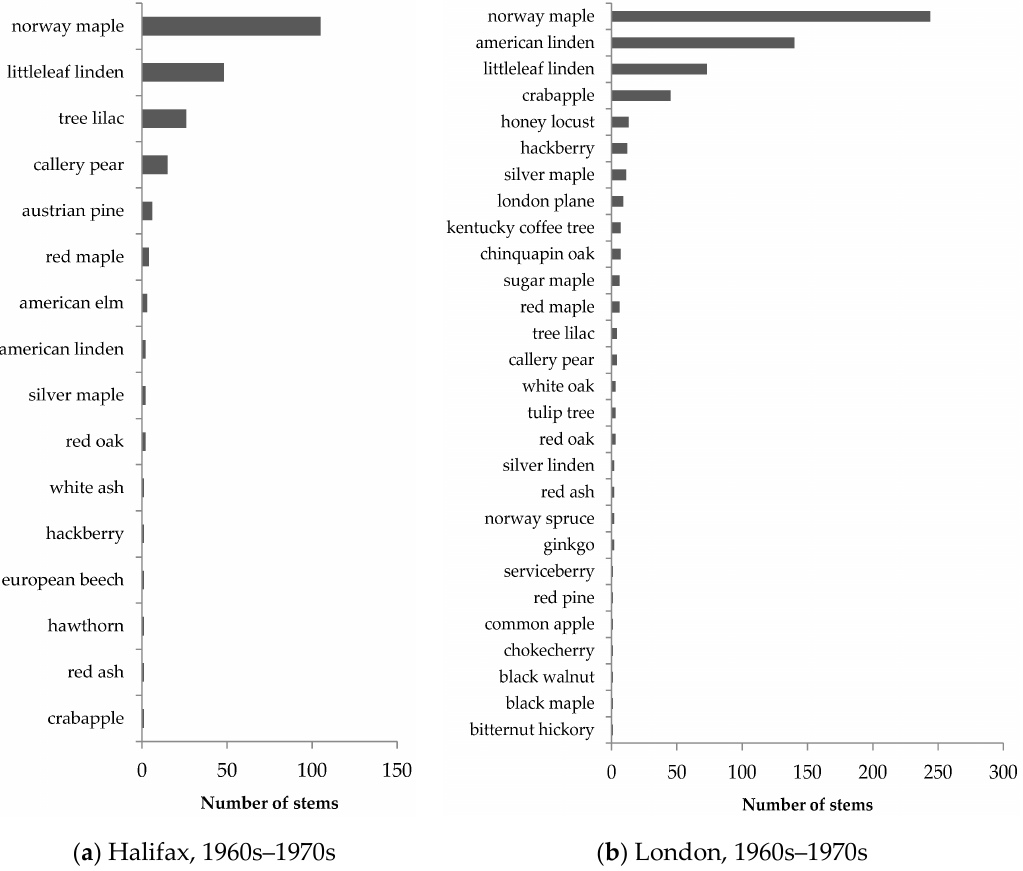
Figure 5. Combined relative species abundance of street trees in neighbourhoods developed 40–50 years ago: ( a ) Relative species abundance of street trees in two neighbourhoods in Halifax; ( b ) Relative species abundance of street trees in two neighbourhoods in London. Table 4. Diversity indices of street tree communities combined according to neighbourhood.